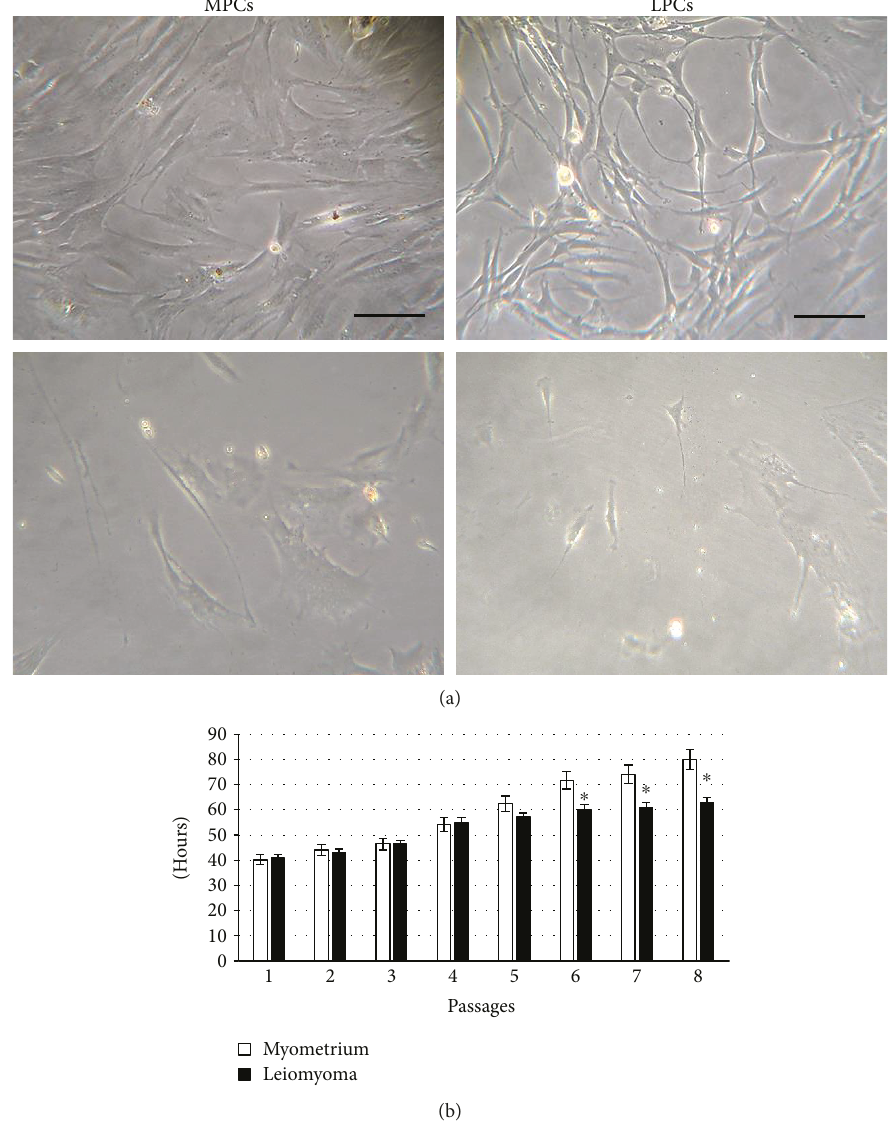
Figure 1: Cell morphology and doubling time. (a) Phase-contrast images of myometrium progenitor cells (MPCs, left) and leiomyoma progenitor cells (LPCs, right) at 2nd (top) and 4th (bottom) passage of culture. Scale bar =100 μ m. (b) Doubling time was calculated over 21 days (8th passage). Data are mean ± SD of experiments performed on 12 samples. ∗ p < 0 05 LPCs versus